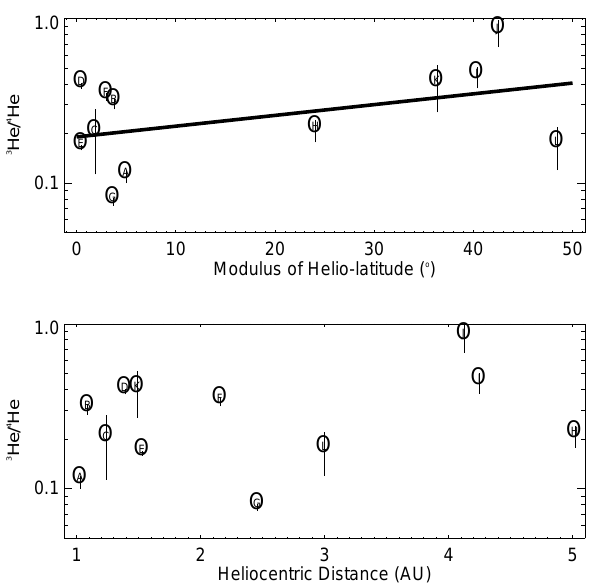
Fig. 4. Values of the derived 3 He/ 4 He ratio for each of the 12 events plotted against helio-latitude (top panel) and heliocentric dis- tance (bottom panel). Statistical errors for each of the two isotope populations are combined to give an estimation of the error in the 3 He/ 4 He ratio. There is an indication that higher values occur with increasing helio-latitude. The straight line drawn in this figure is a least-squares fit to all the data points and has a chi-square value of